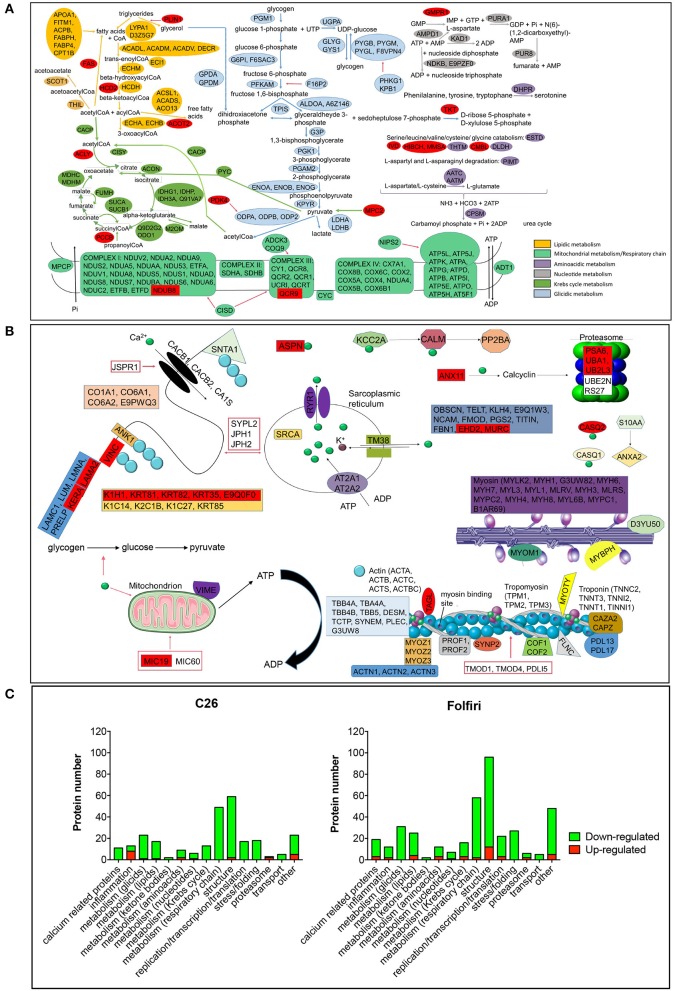
Major pathways affected in cancer- and drug-induced cachexia. (A) Proteins belonging to any metabolic pathway are indicated and classified as shown in color legend (right). Proteins up-regulated in almost one comparison (C26 vs. control or Folfiri vs. vehicle) are shown in red. All other proteins reported are down-regulated. (B) Structural proteins, calcium- and proteasome-associated proteins affected by either cancer or chemotherapy. (C) Number of proteins taking part to any of the major pathways affected in cancer- and chemotherapy-induced cachexia. Up-regulated proteins are reported in red, down-regulated proteins are shown in green.